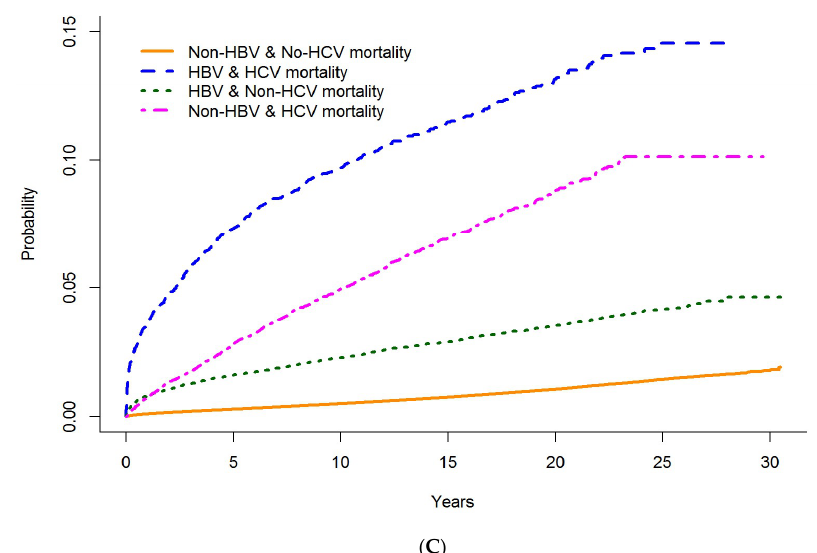
Figure 2. Cumulative mortality rate for people testing HBV positive vs. those testing negative in BC from 1990–2015. ( A ) Cumulative liver-related mortality in individuals with and without HBV infection. ( B ) Cumulative liver-related mortality in individuals with and without HBV infection and co-occurring NAFLD. ( C ) Cumulative liver-related mortality in individuals with and without HBV infection and HCV coinfection.